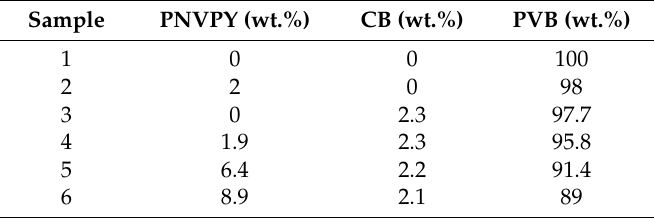
Table 1. The concentration of composite coatings with different ratios of PNVPY/CB/PVB. Sample PNVPY